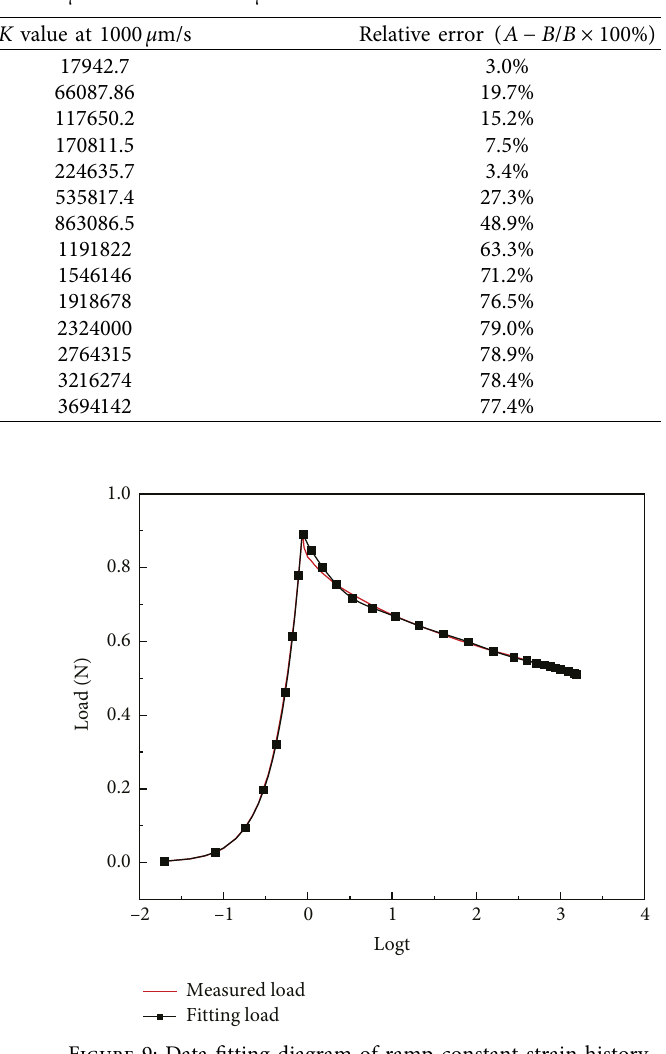
Table 2: Detailed comparison of 100 μ m/s data and 1000 μ m/s data.